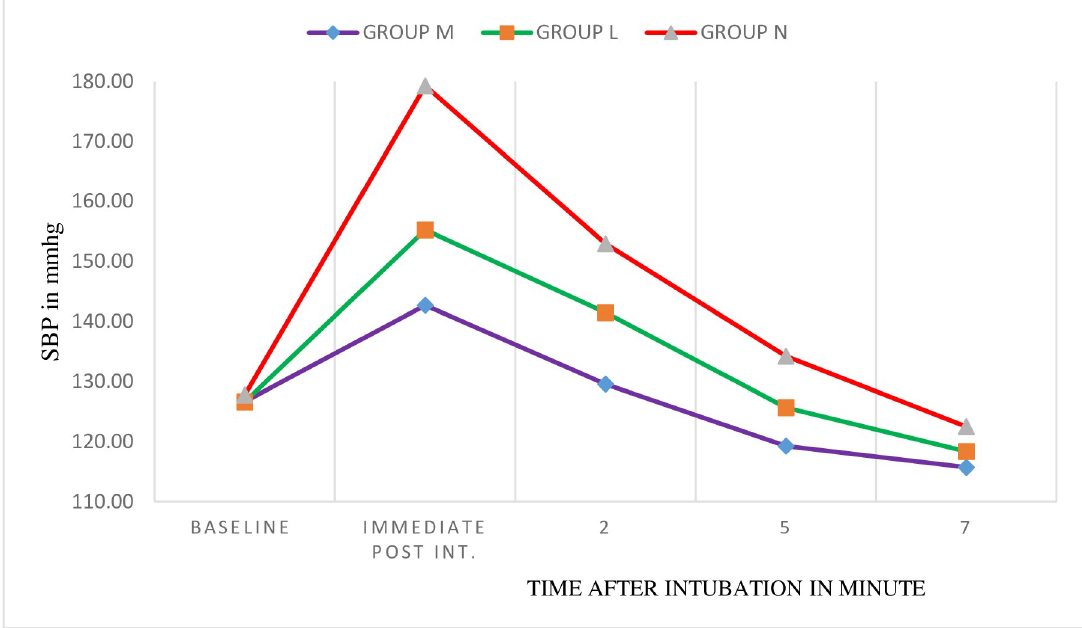
Fig 2. Within-the group change in SBP at different time intervals in Zewditu Memorial Hospital, Addis Ababa, 2018/2019.